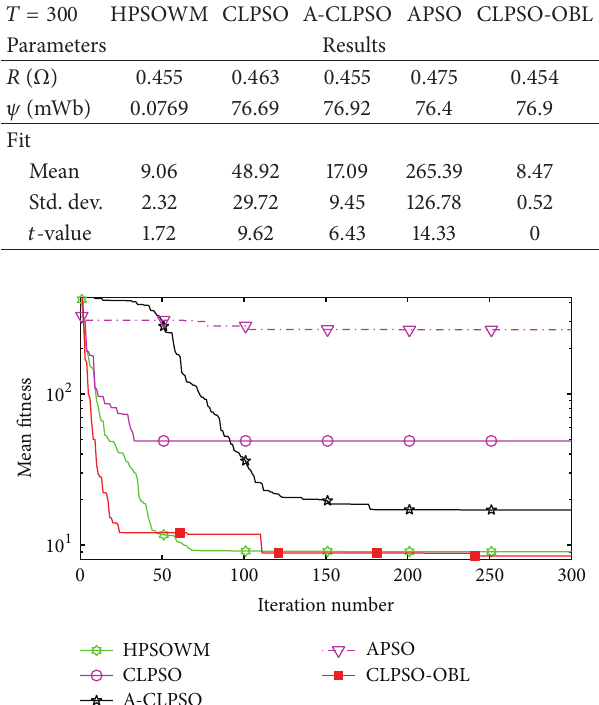
Figure 6: The convergence curve of several PSOs on PMSM parameter estimation under temperature variation (with heating for 20